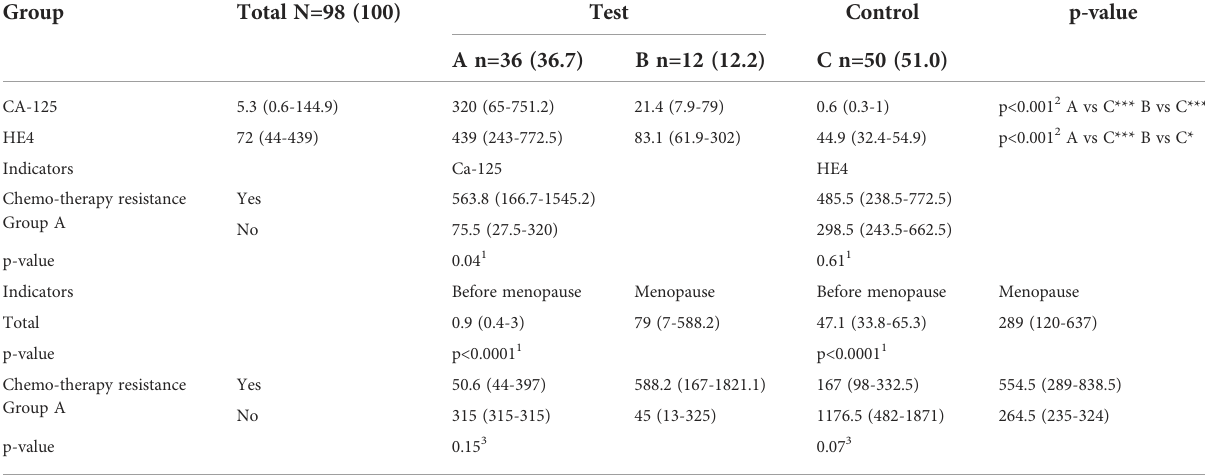
TABLE 3 Concentrations of CA-125 and HE4 in groups of patients with histopathologically con fi rmed diagnosis of ovarian cancer (groups A and B) and control group (C), including patients undergoing chromotherapy (in A group) and menopause (total and in A group).